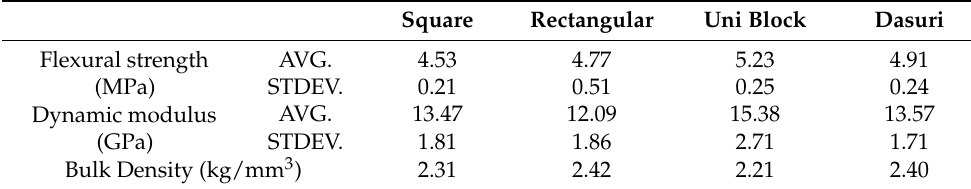
Table 3. Physical properties by block shape.